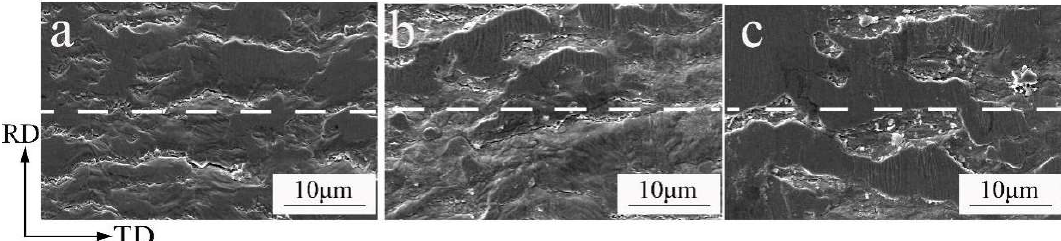
Figure 13. Surface morphology of the copper foil after bending. ( a ) Rolled sample; ( b ) 1 min; ( c ) 3 min.